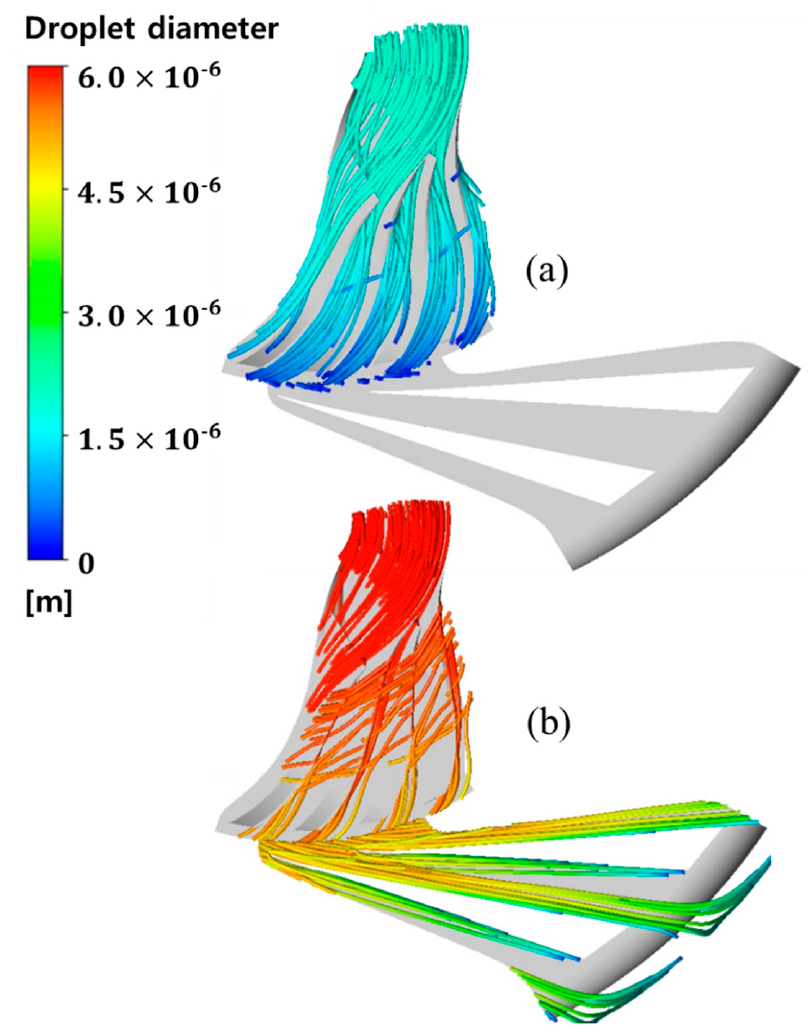
Figure 10. Comparison results of the droplet trajectories for the case of droplet diameter; ( a ) d r = 2 μ m and ( b ) d r = 6 μ m.